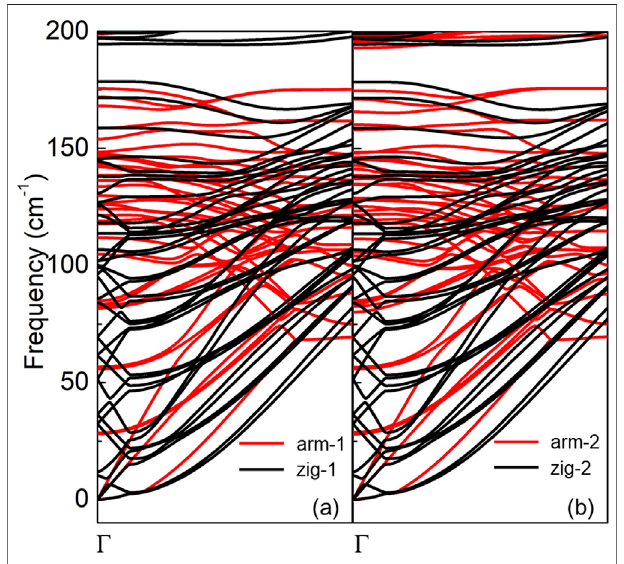
FIGURE 7 | Calculated phonon dispersion for MoSSe/WSSe heterostructure with (A) armchair and (B) zigzag